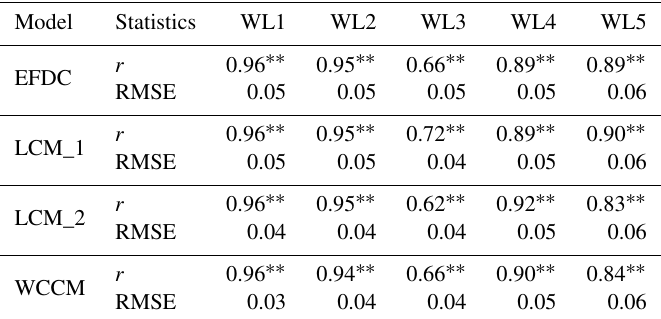
Table 2. Correlation coefficient (r) and root-mean-square error (RMSE) between the simulated and measured water level during 2015 summer observation for the numerical experiments. Note that * indicates p< 0 . 05 and that ** indicates p< 0 . 01.